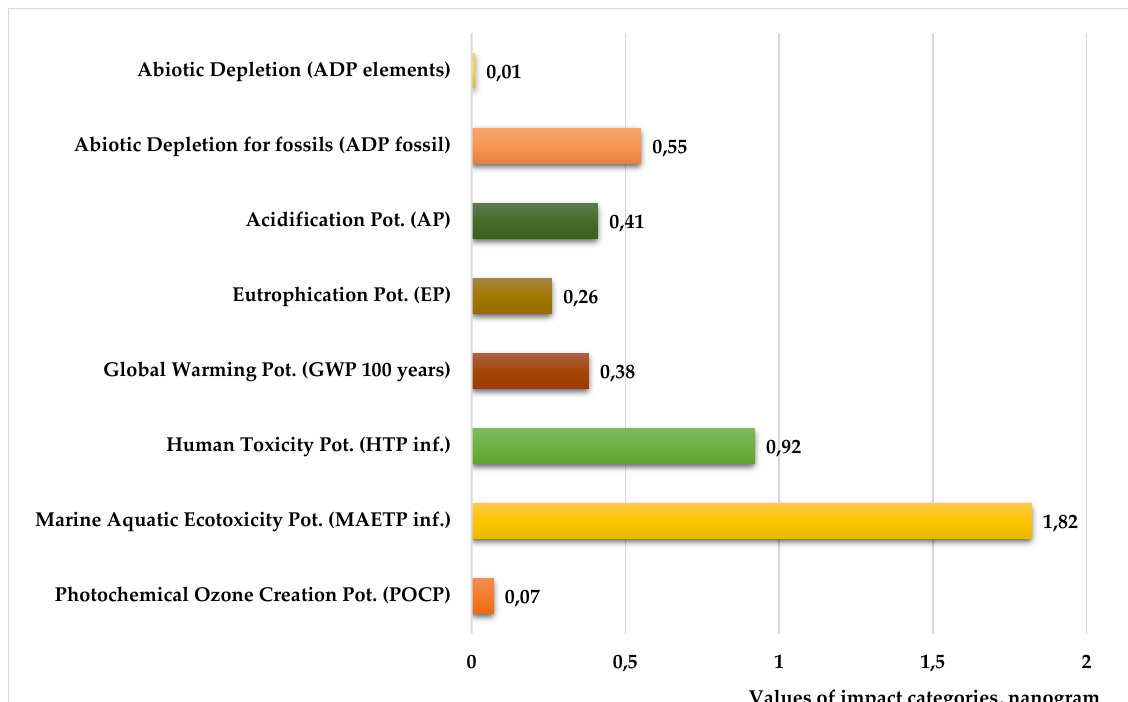
Figure 6. Environmental impact categories in the cooking/frying phase with transport (functional unit: food product of 0.471 kg –1 portion. Normalisation reference: CML 2016, EU 25 + 3, year 2000, excl. biogenic carbon. Weighting method: thinkstep LCIA Survey 2012, Europe, CML 2016, excl. biogenic carbon). Table 2. Environmental impacts in the preparation and cooking/frying phases of the examined product in nanograms (functional unit: one portion product). Normalisation reference: CML 2016, EU 25 + 3, year 2000, excluding biogenic carbon. Weighting method: thinkstep LCIA Survey 2012, Europe, CML 2016, excluding biogenic carbon).